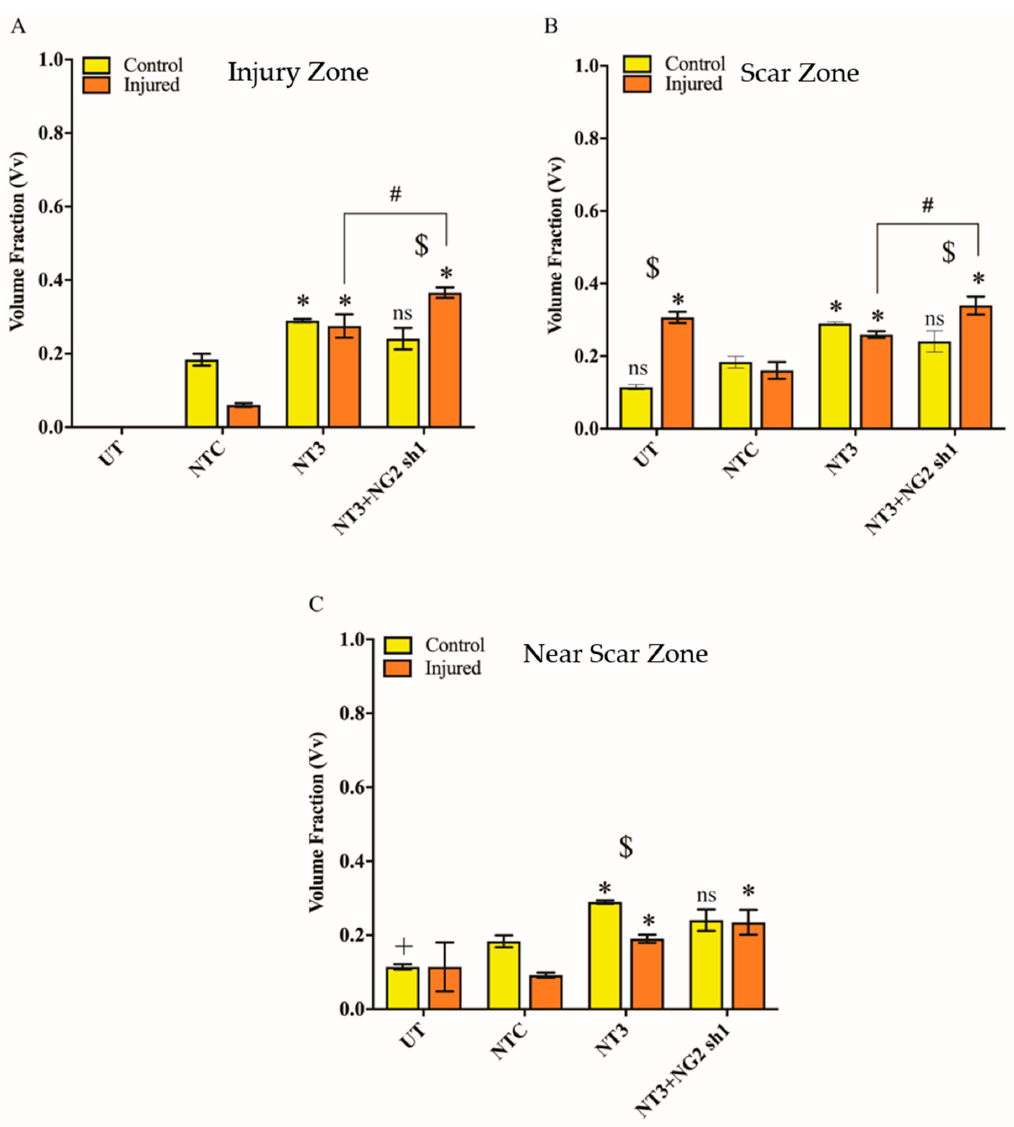
Figure 10. Vv β III-tubulin in untransduced and lentiviral vector transduced control and transection injured ex vivo spinal cord slices. Graphs show Vv β III-tubulin immunohistochemical staining at injured ex vivo spinal cord slices . Graphs show Vv β III-tubulin immunohistochemical staining at the IZ ( A ), SZ ( B ) and NSZ ( C ). UT = untransduced, NTC= non-targeting control. Mean ± SEM. * p ≤ 0.001